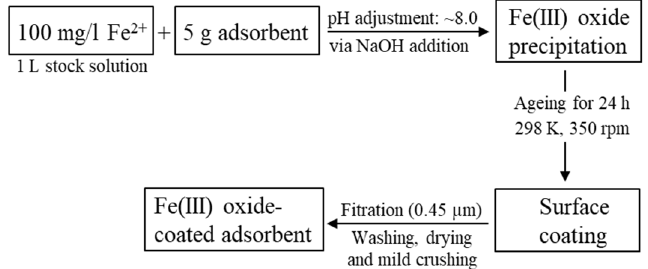
Figure 1. Flow chart showing the preparation of the Fe(III) oxide-coated adsorbents.